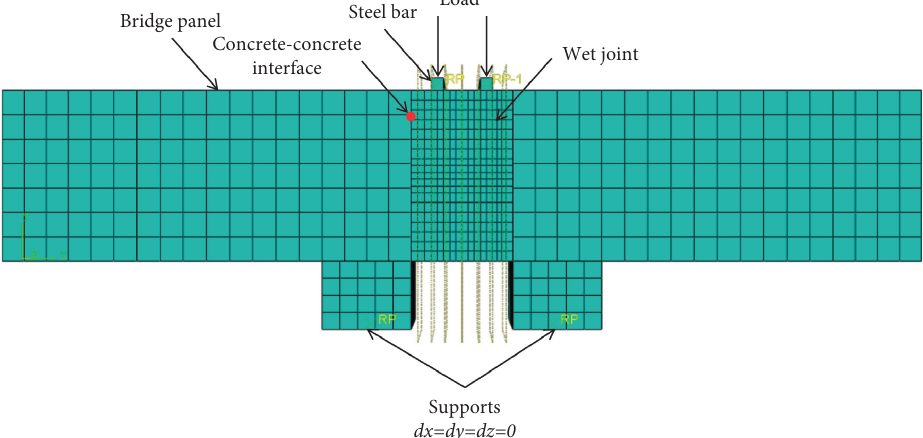
Figure 17: Mesh, boundary condition, and loading condition.